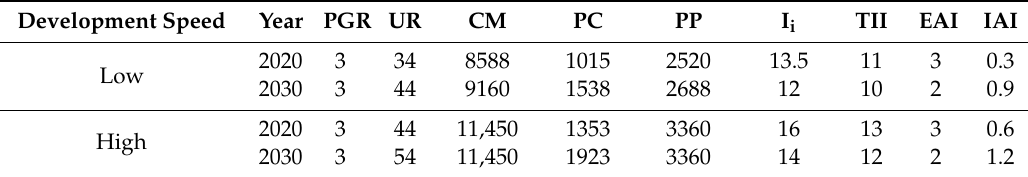
Table 1. Forecast of social and economic development speed in di ff erent planning levels. Population growth rate (PGR, %), urbanization rate (UR, %), coal mine (CM, 10 4 ton), petrochemical (PC, 10 8 ton), power plant (PP, 10 4 KW), industrial increased (I i , %), tertiary industry increased (TII, %), ecological area increased (EAI, %), and irrigation area increased (IAI, %), were selected to measure the development of social economy. Development Speed Year PGR UR CM PC